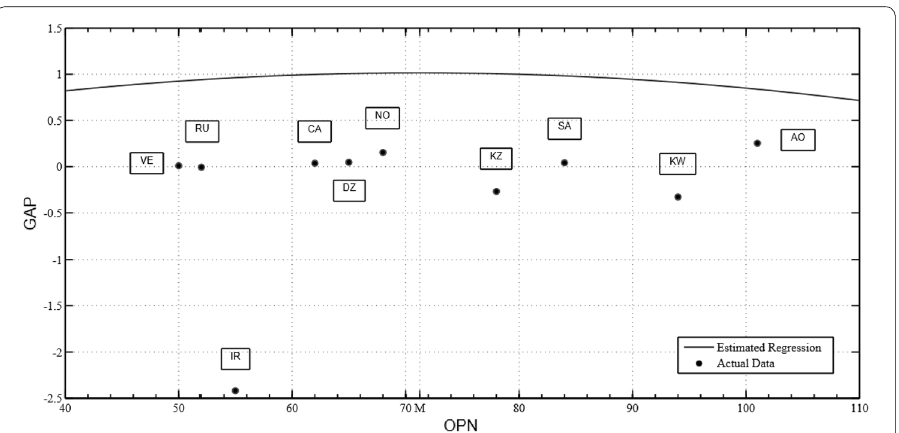
Fig. 5 Gap of brown and green growth versus openness in the ten oil-exporting countries: the actual data in 2012 and the estimated curve of model